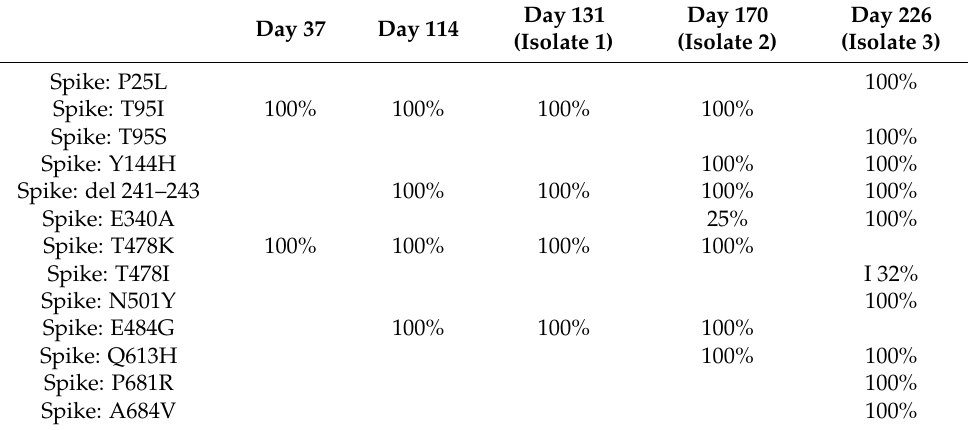
Table 1. Acquired mutations in the Spike protein observed during patient monitoring, with relative prevalence (%). All the five strains containing the listed mutations in the Spike gene belong to the AY.4.2 (B.1.617.2.4.2) strain, with 99.9% similarity throughout the whole genome compared to the original viral sequence (Day 37), with a maximum of 20 amino acid